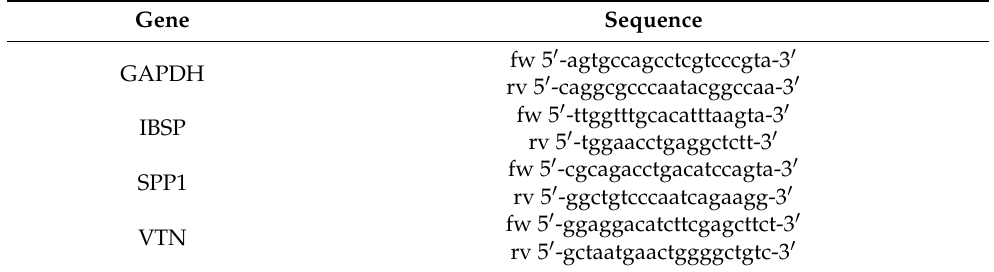
Table 3. Oligonucleotide sequences of the genes evaluated by quantitative PCR. Gene